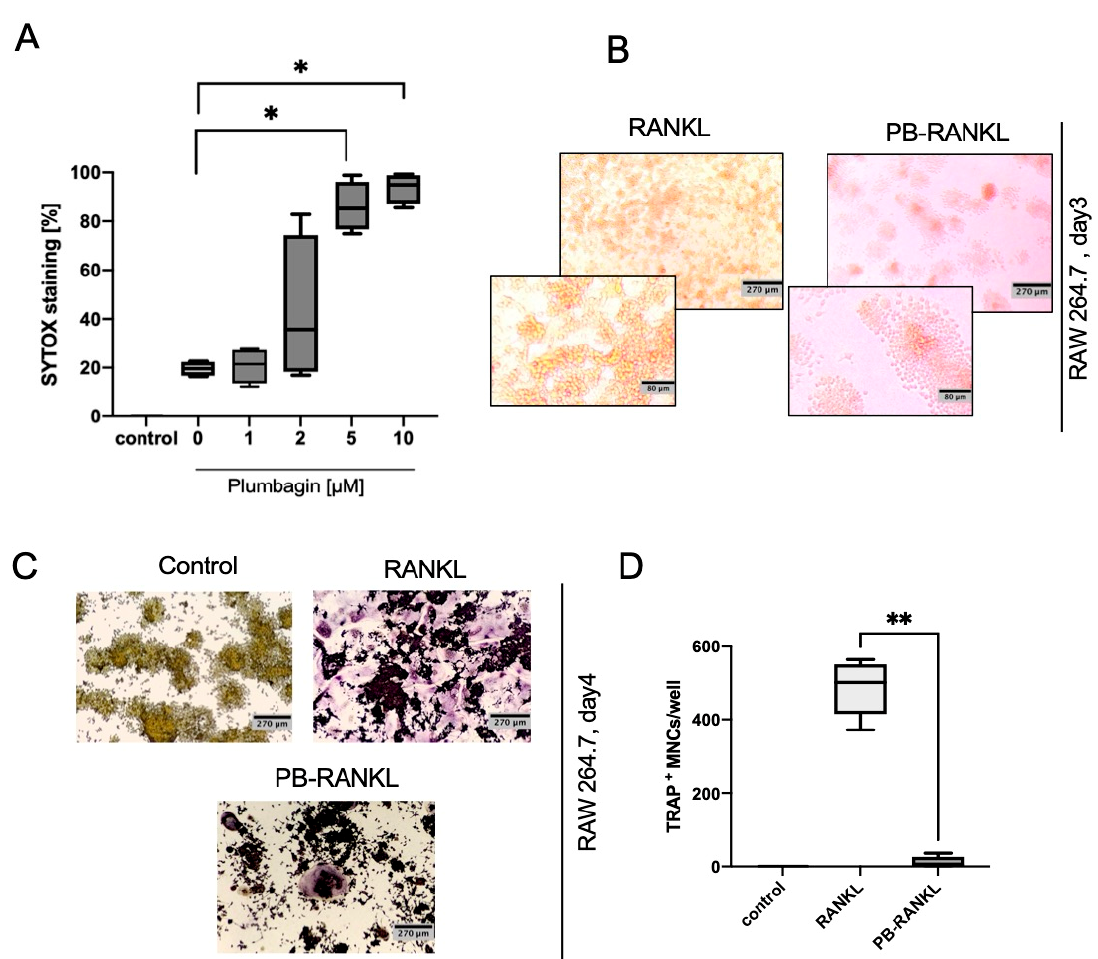
Figure 4. Plumbagin inhibits osteoclastogenesis in RAW264.7 macrophages. ( A ) RAW264.7 cells were treated with increasing concentrations of plumbagin for 24 h and cell viability was measured after incubation with SYTOX. Statistical analysis was performed comparing the results to the control in using a Mann–Whitney test ( n = 4); ( B , C ) and ( D ) RAW264.7 cells were seeded in a 24 well plate and treated with RANKL or plumbagin (1 µ M) /RANKL. On day 3, cells were restimulated with RANKL, plumbagin/RANKL, respectively, until the osteoclasts were fully differentiated; ( B ) shows representative pictures and ( C ) the quantification of TRAP stains ( n = 3, with duplicates); ( D ) one day before the TRAP staining was performed, light microscopic pictures (magnification 100 × ) were taken to document cell viability and cell numbers. *: p ≤ 0.05; **: p ≤ 0.01.